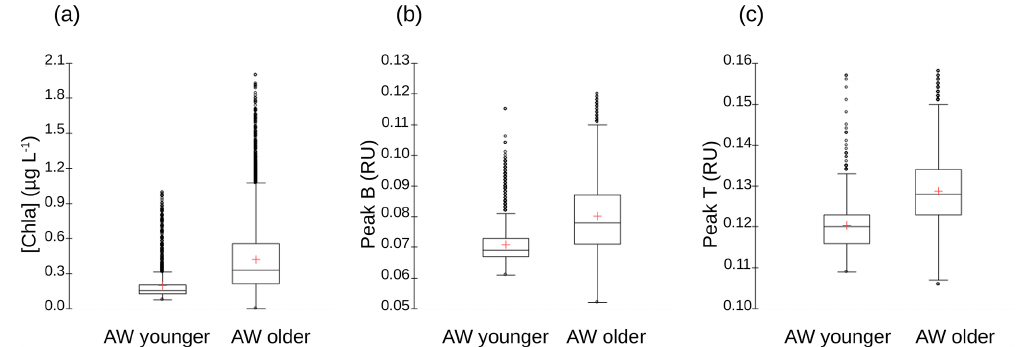
Figure A5. Box-and-whisker plots for the comparison of (a) [chl a ] (in micrograms per liter), (b) fluorescence intensities of tyrosine-like fluorophore (peak B in RU) and (c) fluorescence intensities of tryptophan-like fluorophore (peak T in RU) between younger and older AW. The bottom and top of the box are the 25th and 75th percentiles, respectively, whereas the central line is the 50th percentile (the median), and the cross is the mean. The ends of the error bars correspond to the 10th percentile (bottom) and to 90th percentile (top). All the SeaExplorer glider transects are considered here (all data acquired from 6 to 15 May 2018). Younger AW corresponds to samples showing salinity between 37.20 and 37.84 and temperature between 14.5 and 17.4 ◦ C ( n = 1657). Older AW corresponds to samples with salinity between 37.82 and 38.14 and temperature between 14.0 and 18.3 ◦ C ( n = 11760). Mean values of chl a , peak B and peak T of older AW are significantly higher than those of younger AW ( t test, p < 0 .